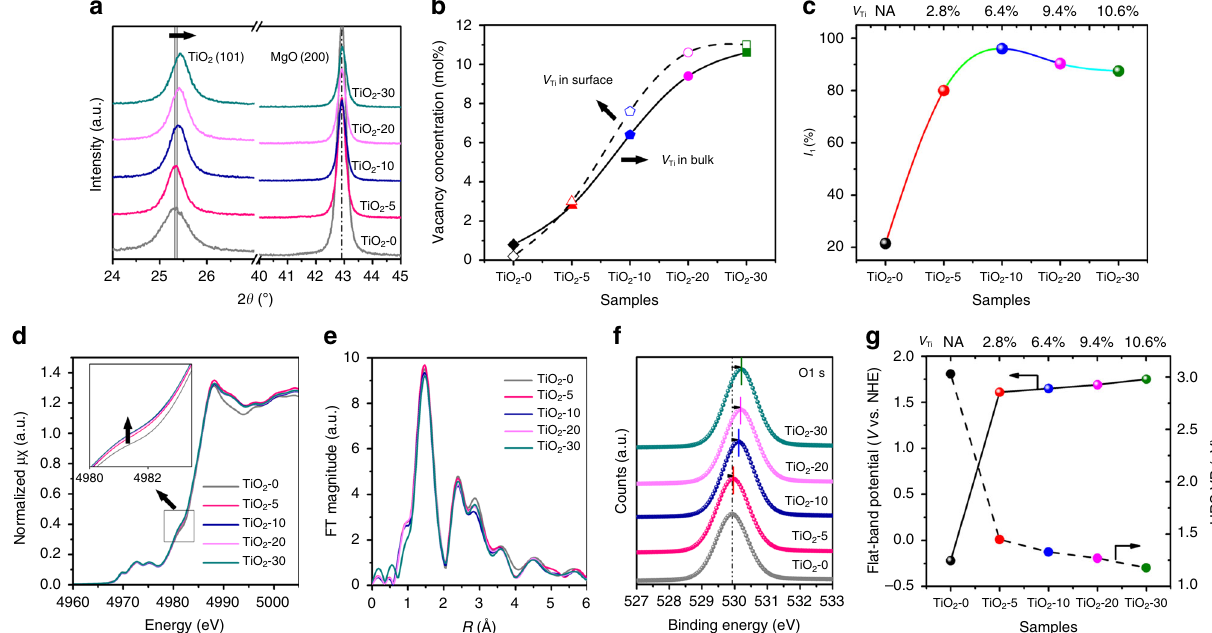
Fig. 2 Defect characterizations of metal-defected TiO 2 . a Enlarged XRD patterns (with 2 θ in the range of 24° – 45°); b Vacancy concentration of TiO 2 in bulk and surface (determined by chemical titration and XPS analysis, respectively); c Intensity of monovacancies from positron annihilation lifetime spectra (PALS), in which I 1 is the relative intensity of τ 1 (metal monovacancies); d X-ray absorption near edge structure (XANES) and e Fourier transforms of k -space oscillations of Ti K edge; f high-resolution O1s XPS spectra ( fi tted); g The positions of fl at-band potential and UV-photoelectron spectroscopy (UPS) VB (valance band) binding